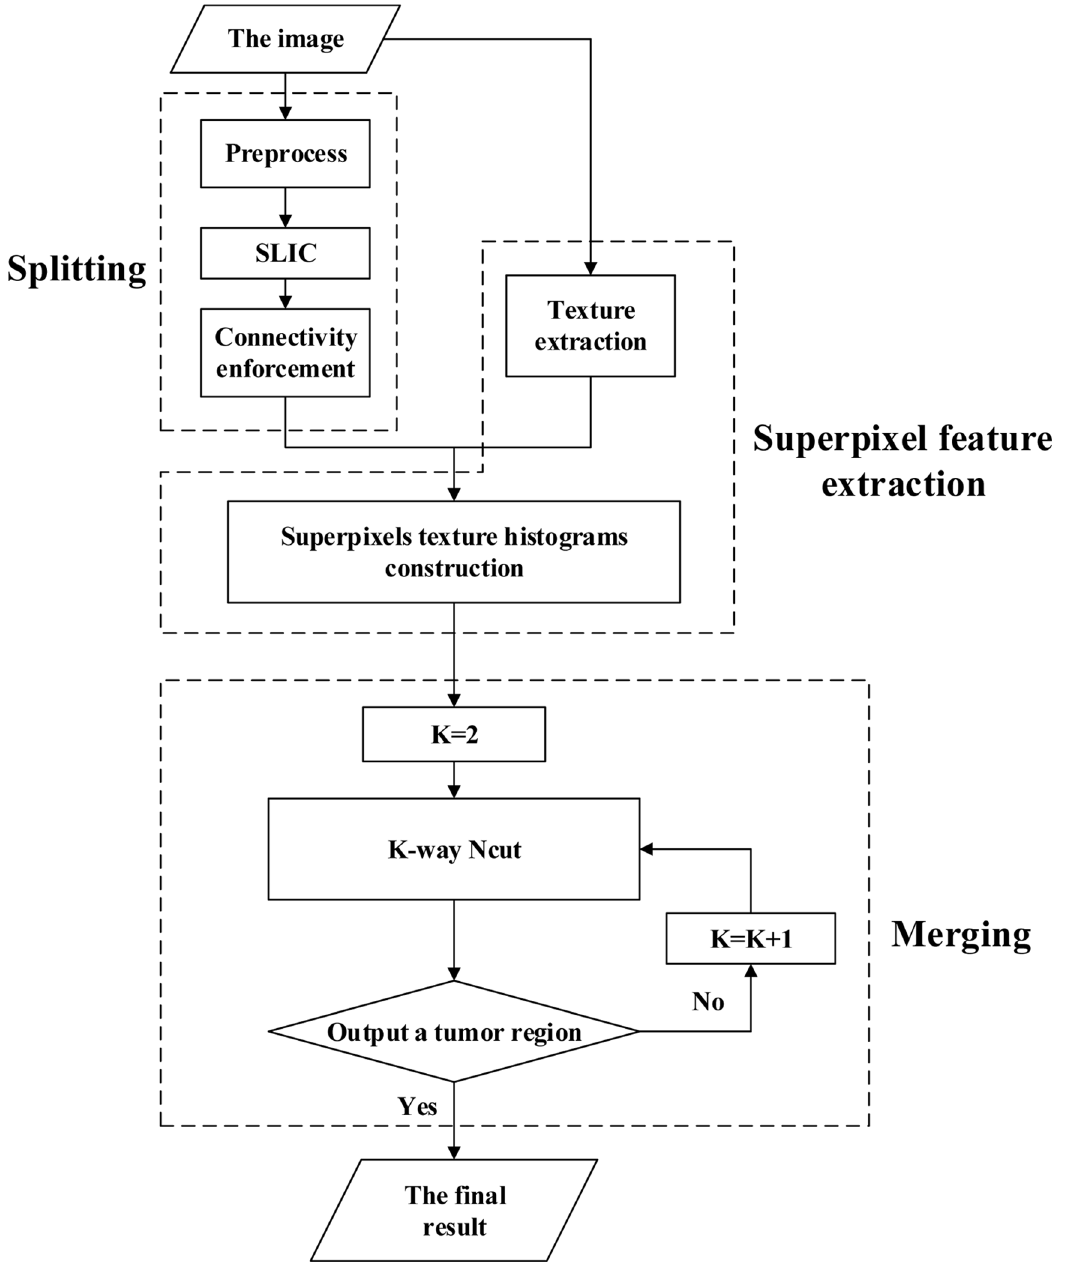
Fig 1. Flowchart of the proposed